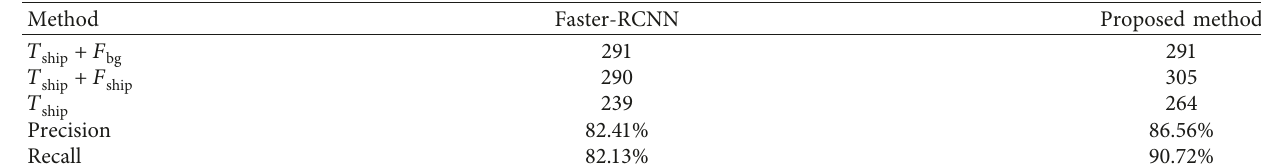
Table 7: Comparison of ship target detection